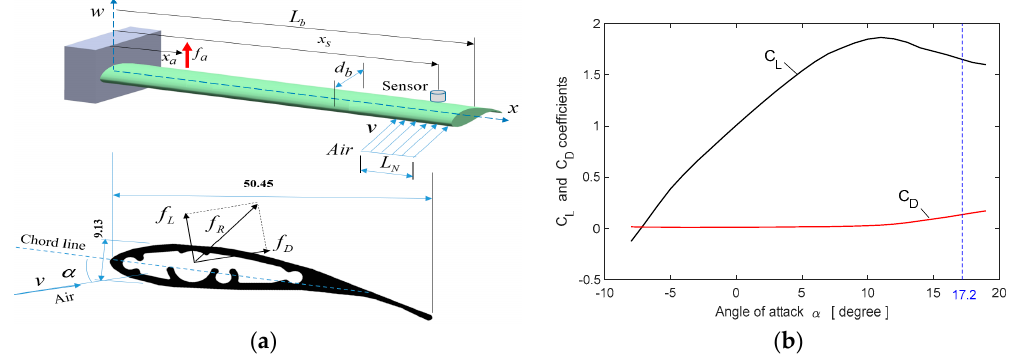
Figure 9. Aerodynamic load ( a ) the blade layout, ( b ) variation of the lift and drag coefficients.